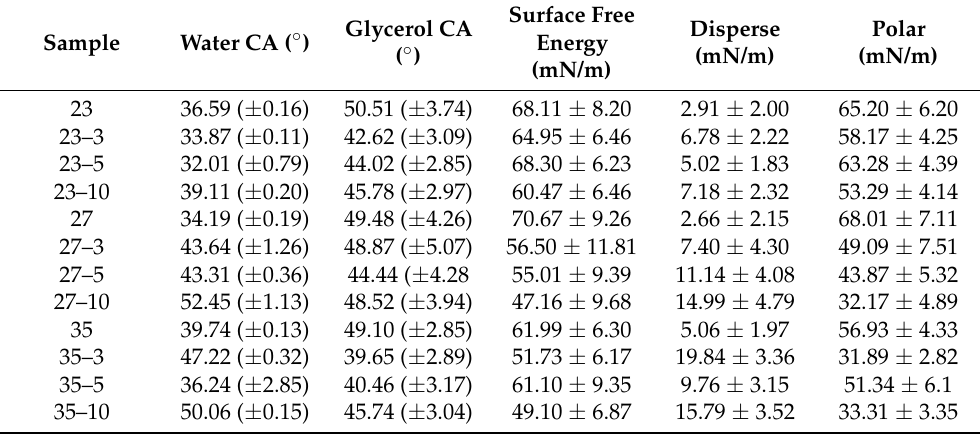
Table 4. Water and glycerol contact angle (CA), surface free energy with a dispersed, and polar